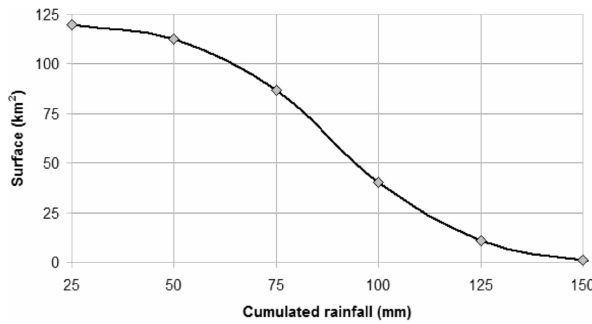
Fig. 6. Distribution of exceedance areas, i.e. the areas over which the event-cumulated rainfall exceeded various